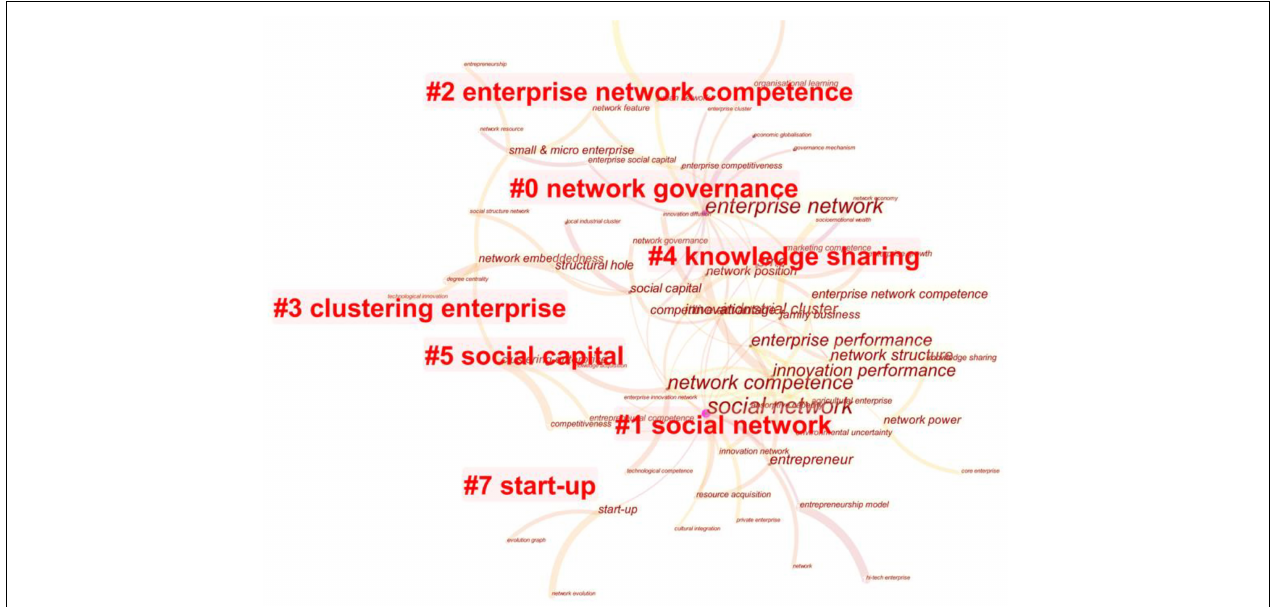
FIGURE 5 | Clusters of high-frequency